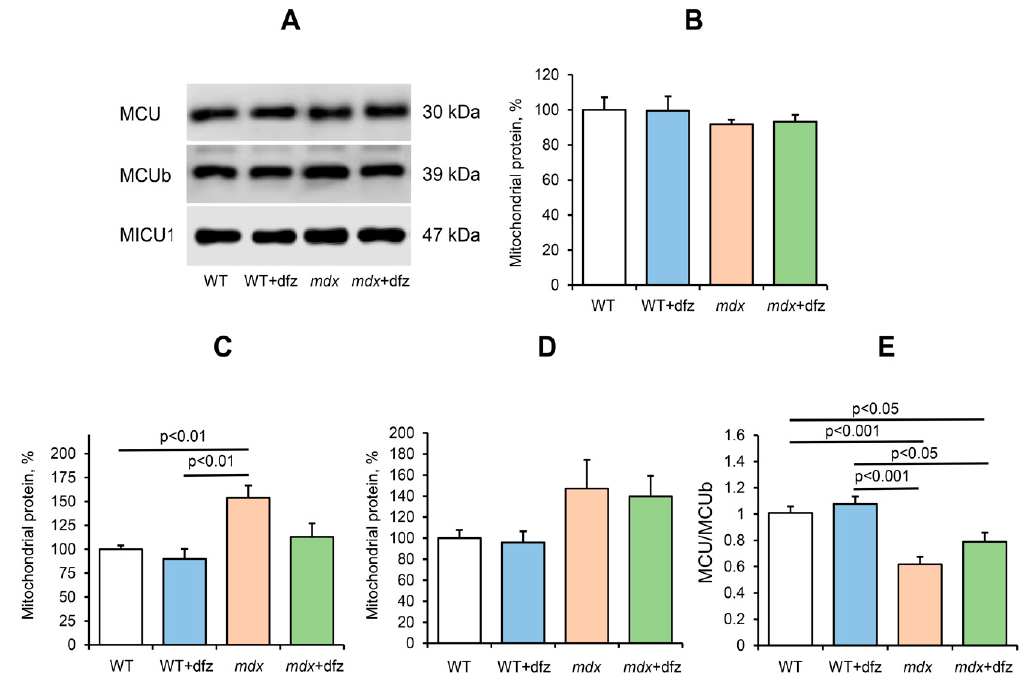
Figure 6. Levels of the proteins of the mitochondrial Ca 2 + uniporter in the skeletal-muscle mitochondria of the studied groups of mice. Data of Western blot analysis ( A ). Relative contents of MCU ( B ), MCUb ( C ), MICU1 ( D ) subunits. MCU / MCUb ratio in mitochondria of studied groups of mice ( E ). The data are presented as means ± SEM ( n = 6).